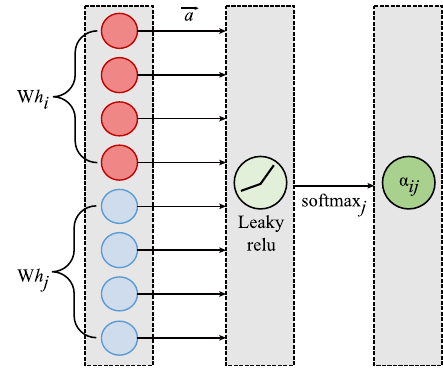
Fig. 3 Attention mechanism of node v i to node v